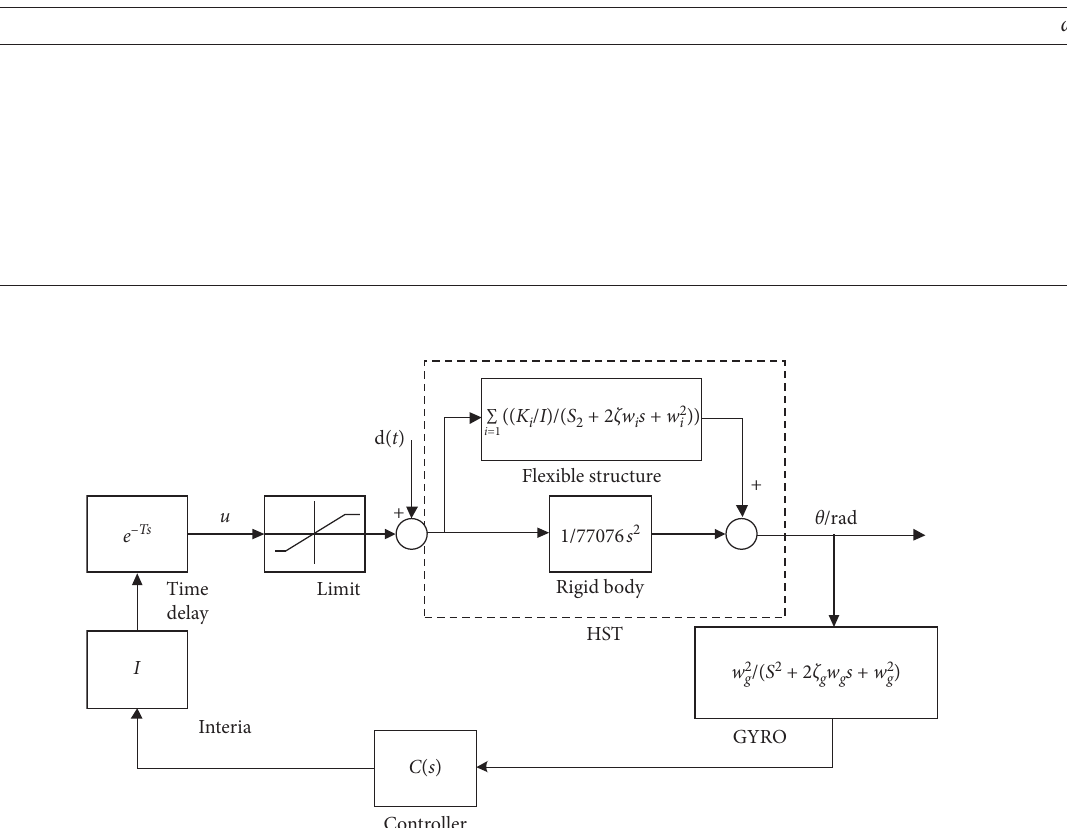
Figure 1: Diagram of Hubble Space Telescope structure. Table 1: Hubble Space Telescope modal data [7].